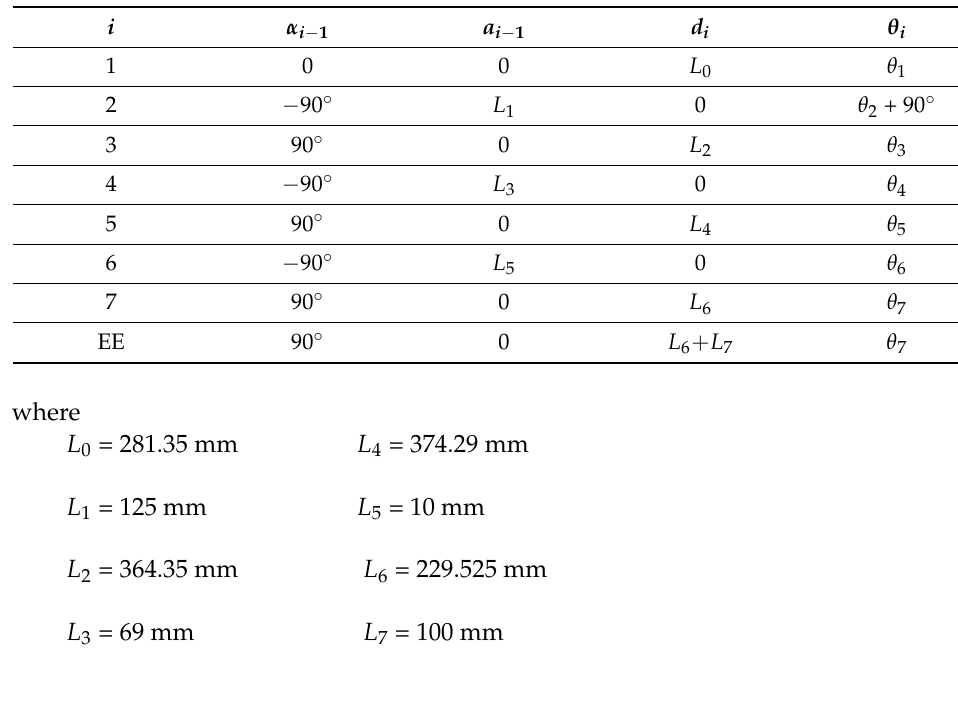
Table 1. Denavit–Hartenberg